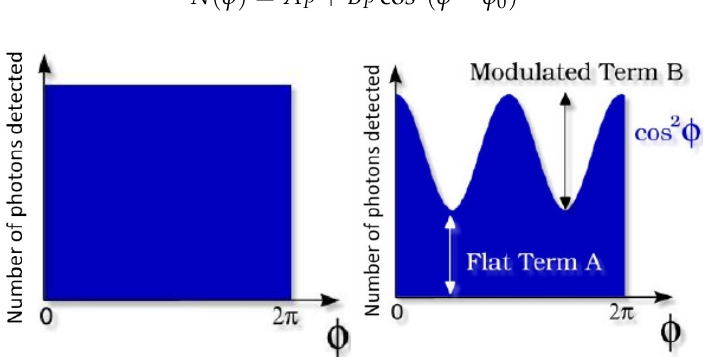
Figure 1. On the left panel: General view of the response of a polarimeter. The detector response to unpolarised radiation is flat since all the angular directions have the same probability. On the right panel: The detector response to the polarized radiation is modulated since one angular direction is more